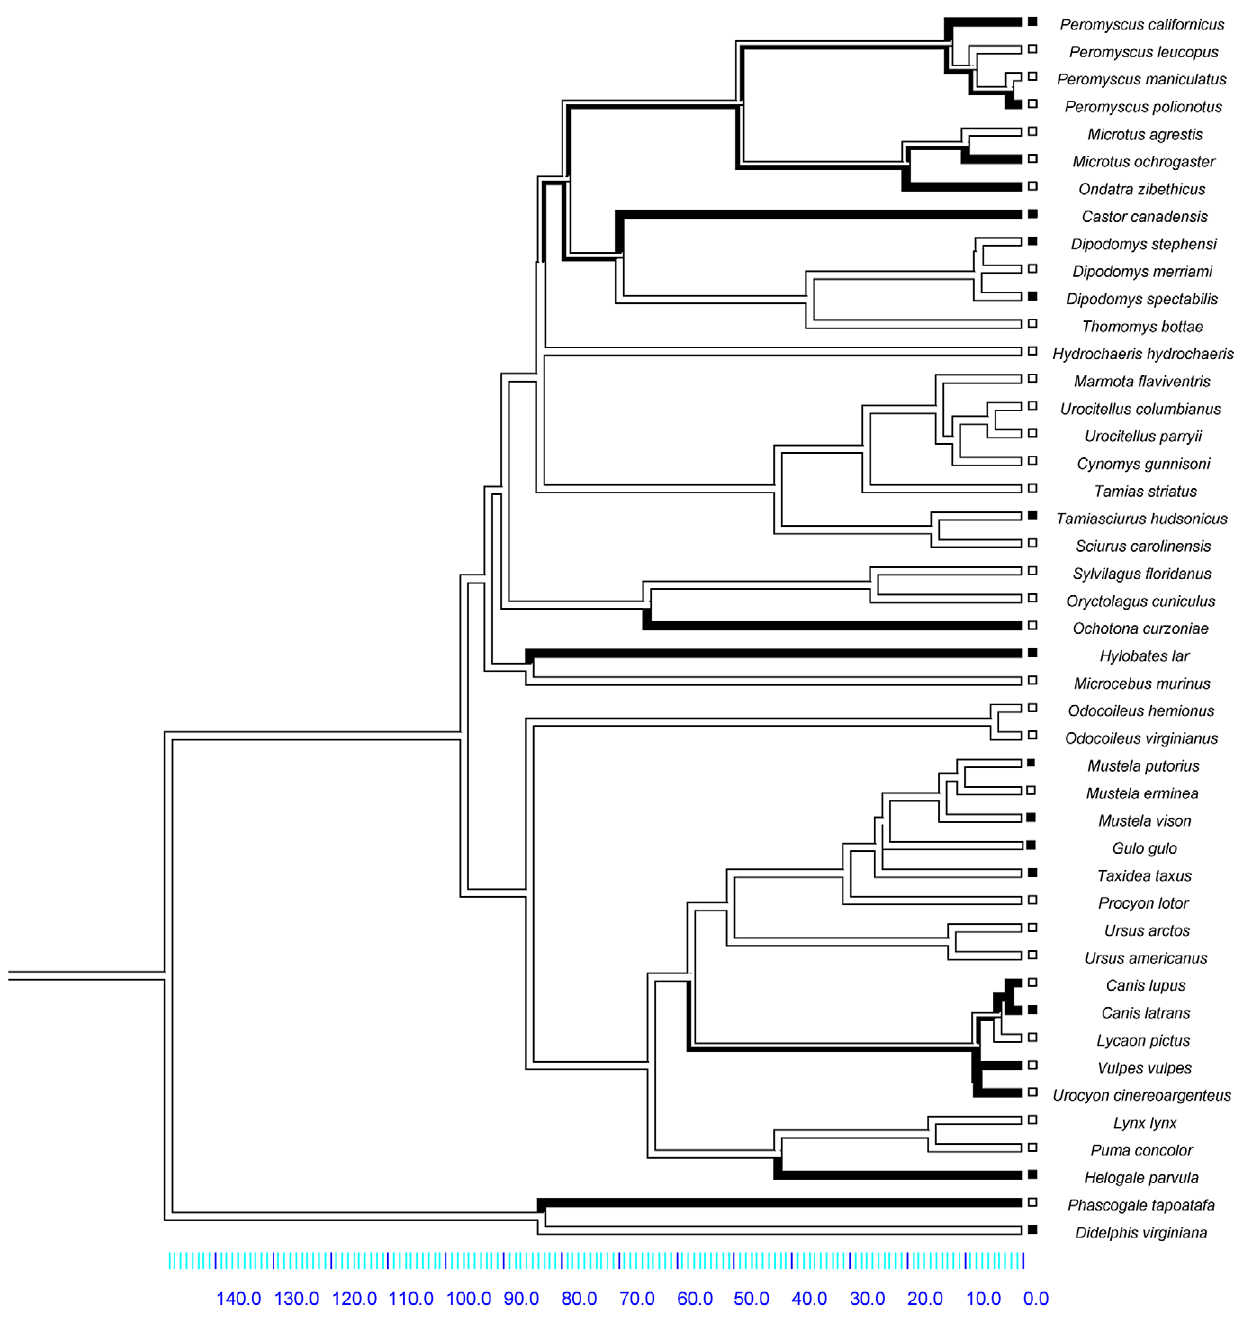
Figure 1. Phylogeny used for the analysis of the mammalian dispersal distance dataset. Time is shown in millions of years. Social mating system is traced over the branches; social non-monogamy (the ancestral state) is represented by white branches and social monogamy is represented by black branches. The boxes represent character states for sex-biased dispersal, with white boxes for species with MBD and black boxes for species with FBD.